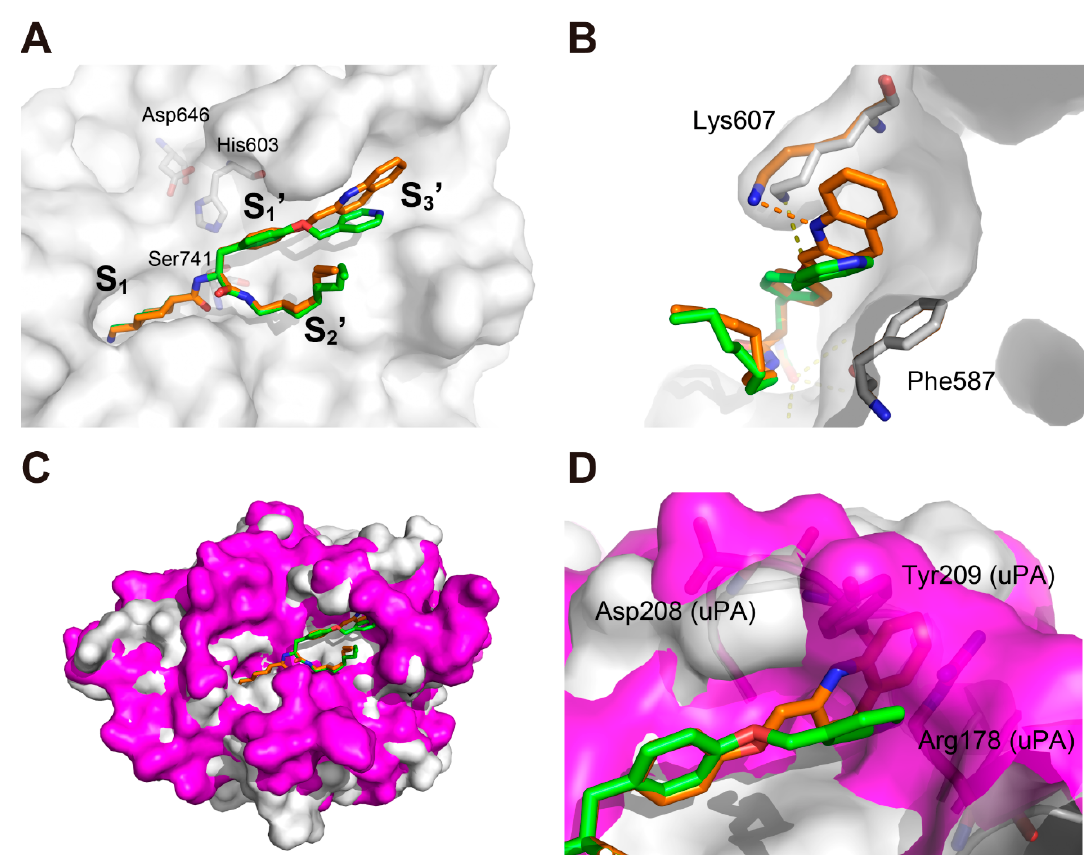
Figure 2. Tranexamic acid ( TXA) derivatives bond with μ Plm. ( a ) Binding orientation of 36 (green stick, pdb 5ugg) and 39 (orange stick, pdb 5ugg) at the sub-site S1 to S1 ′ , S2 ′ , and S3 ′ ; ( b ) Picolyl and quinolinyl moieties extended from Tyr side chain in the S3 ′ pocket; ( c ) Superimposition of the active sites of μ Plm (white molecular surface, pdb 5ugd) and uPA (magenta molecular surface, pdb 1fv9); ( d ) Close up view of the S3 ′ pockets; The quinoline moiety collides with both Tyr209 and Arg178 residues of at the S3 ′ site of uPA. *The numbers of amino acid residues correspond to full-length Plm or uPA.